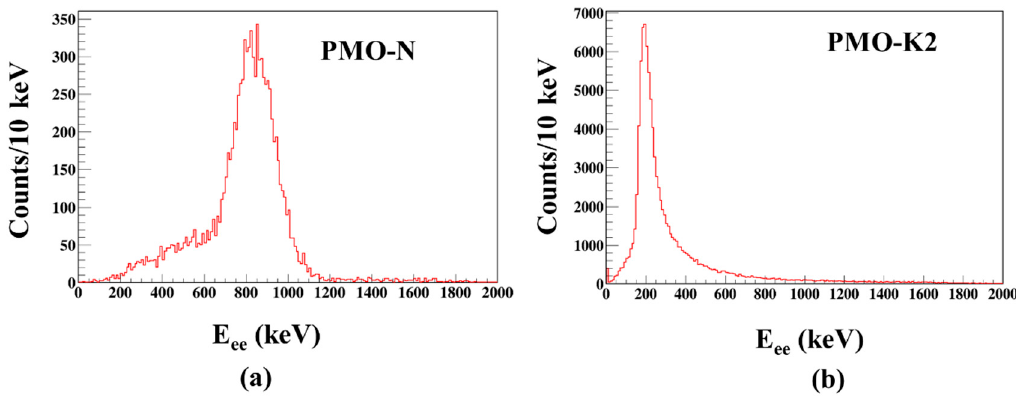
Figure 8. Total background spectra of ( a ) PMO-N and ( b ) PMO-K2 measured at 50 K over six hours.